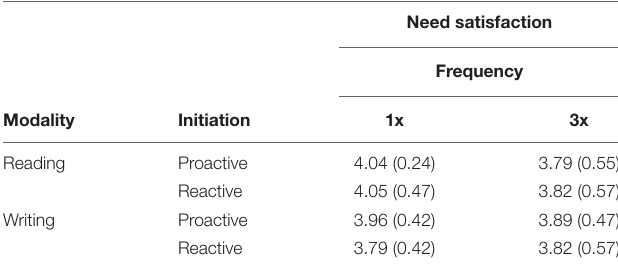
TABLE 4 | Mean need satisfaction (SDs in parentheses) as a function of modality of phubbing (reading vs. writing), initiation of phubbing (proactive vs. reactive), and phubbing